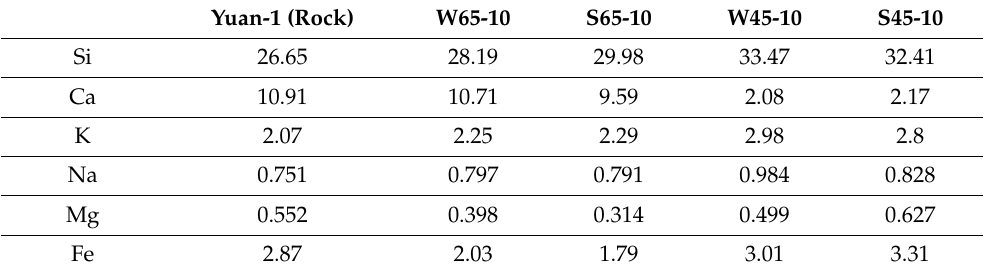
Table 4. Contents of major elements in core rock before and after water–rock interaction (in wt%).